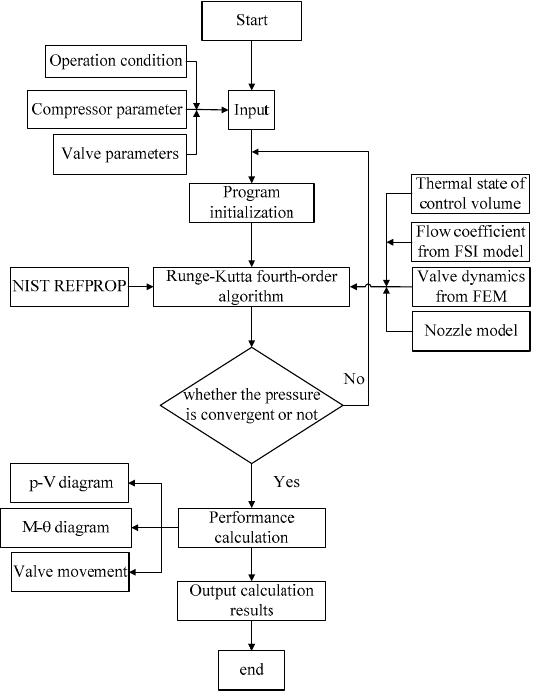
Figure 5. Flow chart for thermodynamic model of refrigerator compressor.